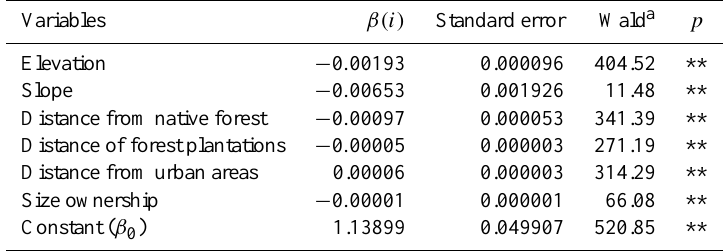
Table 5. Results of the adjustment of the logistic regression for forest plantation sprawl (**= p < 0 . 01). Variables